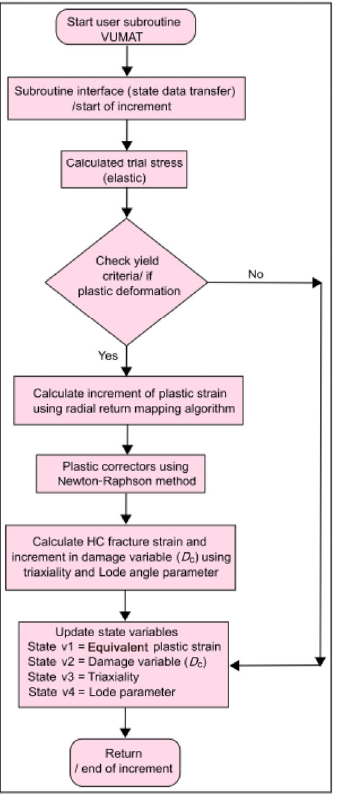
Fig. 8 Flow chart of VUMAT subroutine for HC fracture model.